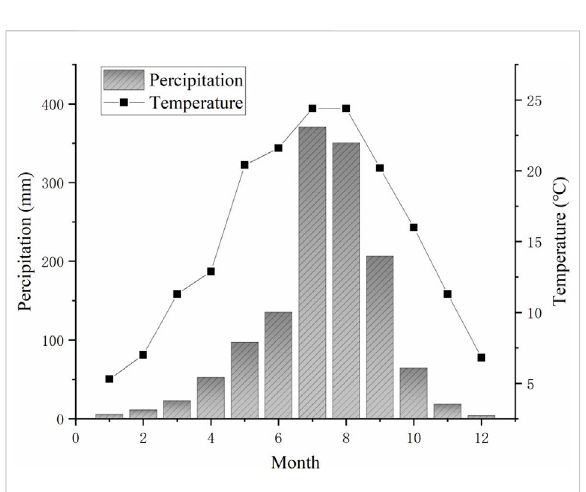
FIGURE 6 Average temperature and precipitation in the meizoseismal area from 1965 to